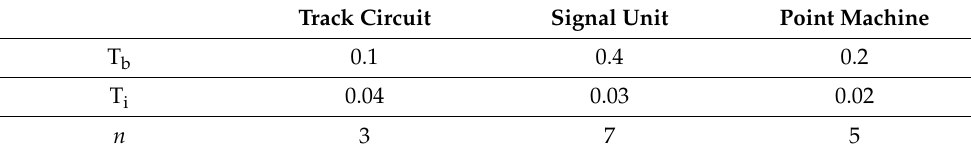
Table 1. The number of inspections of different signalling subsystems by Model 1.